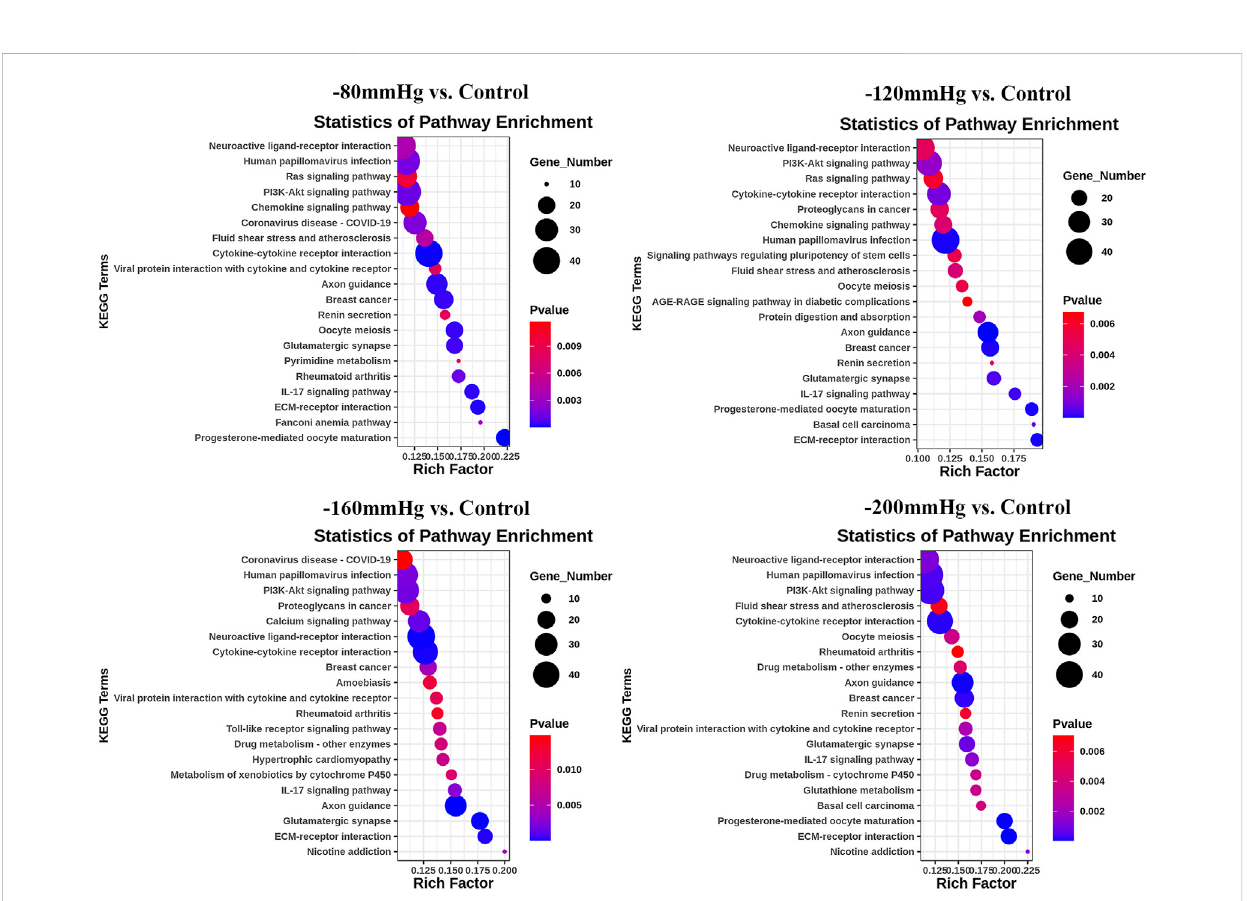
FIGURE 11 KEGG analysis of DEGs in − 80 mmHg vs. control, − 120 mmHg vs. control, − 160 mmHg vs. control, and − 200 mmHg vs.